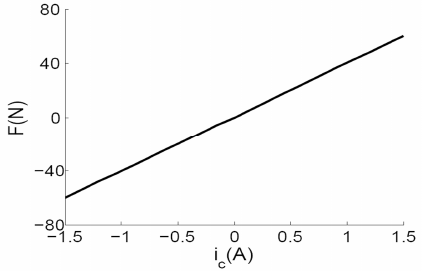
Figure 6. Force-current/displacement characteristic of the radial